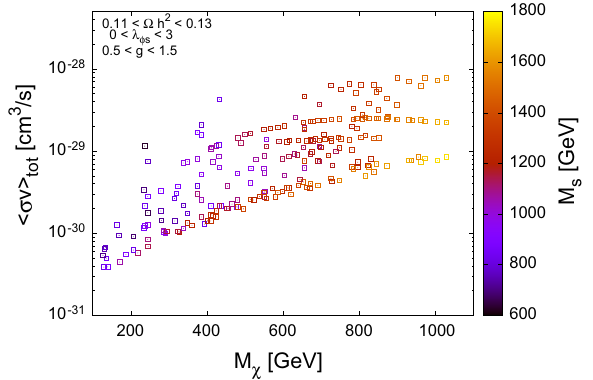
Fig. 8 Dependence of velocity-averaged annihilation cross section on DM mass indirect detection experiments limits. Figure 8 shows that